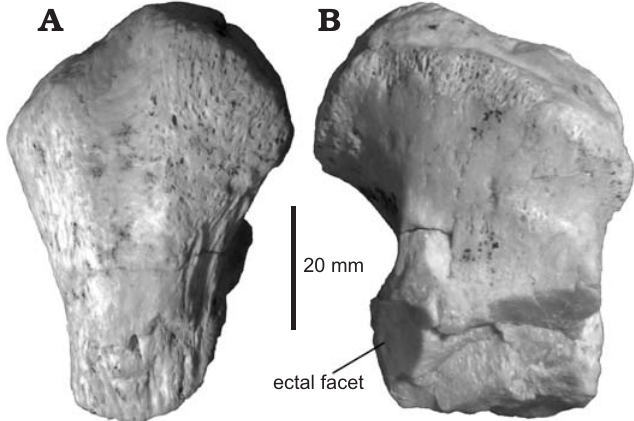
Fig. 3. Toxodontidae gen. et sp. indet. from Quebrada Fiera, Mendoza, Argentina; Deseadan SALMA (late Oligocene), MCNAM-PV 3907, left calcaneum fragment, posterior ( A ) and anterior ( B ) views.